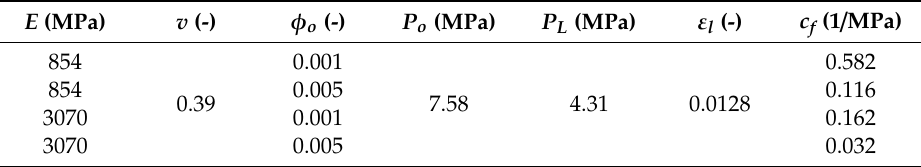
Table 1. Boomer Well B-1 San Juan Basin [1,2].